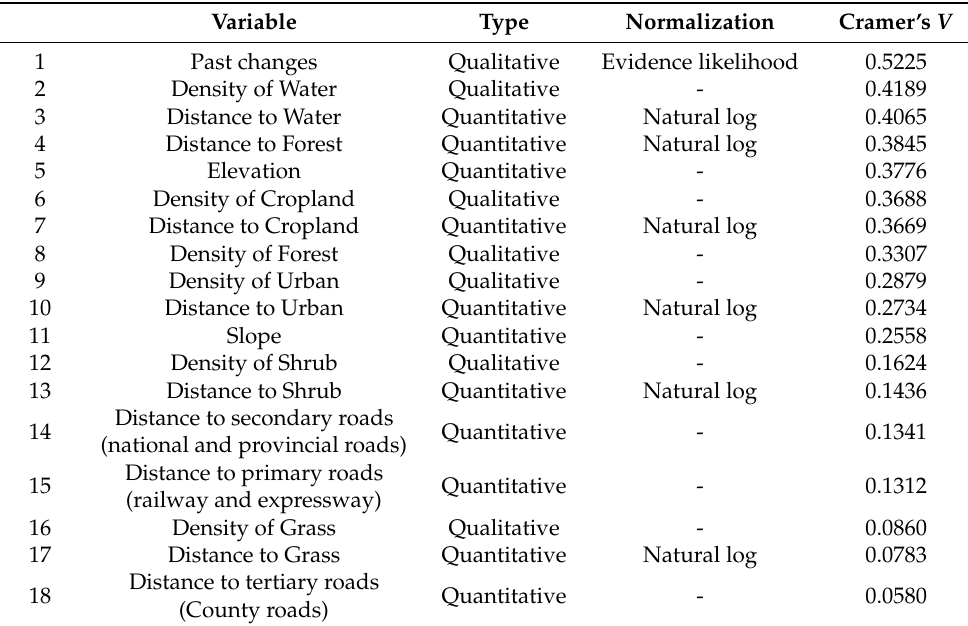
Table 6. Explanatory variables in land change modeling and their Cramer’s V